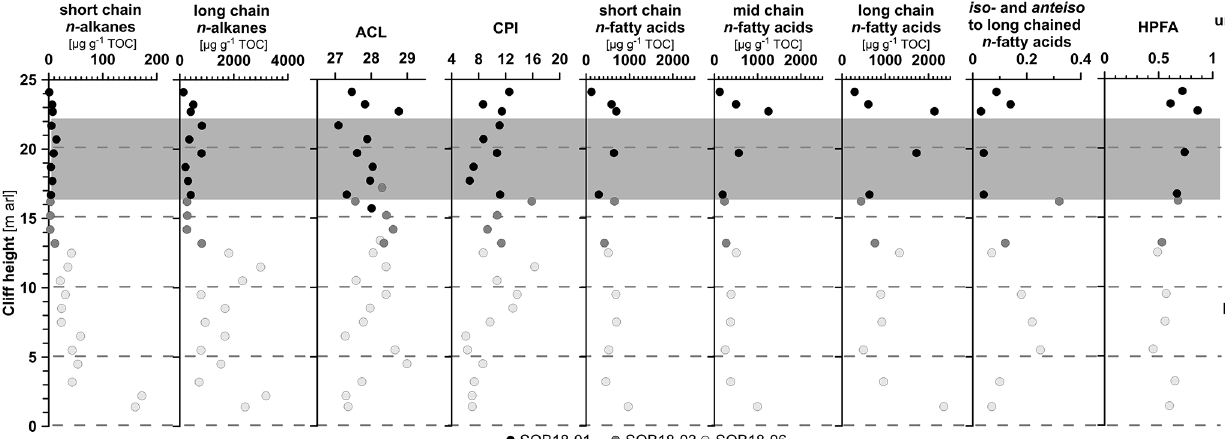
Figure 3. Biomarker parameters of the Sobo-Sise Yedoma cliff. The first four columns show n -alkane parameters: short-chain (C 14 –C 20 ) , and long-chain (C 21 –C 33 ) n -alkane concentrations (both in µgg − 1 TOC), the n -alkane average chain length (ACL 23 − 33 ) , and n -alkane carbon preference index (CPI 23 − 33 ) . The last five columns show n -fatty-acid parameters: short-chain (C 8 –C 20 ) , mid-chain (C 21 –C 23 ) and long-chain (C 24 –C 32 ) n -fatty-acid concentrations (inµgg − 1 TOC); the ratio of iso- and anteiso-branched saturated fatty acids (C 11 , C 13 , C 15 and C 17 ) to mid- and long-chain (C ≥ 21) n -fatty acids; and the higher plant fatty acid (HPFA) index. Data points are displayed over cliff height from the cliff top at 25m above river level (a.r.l.) to cliff bottom at 0ma.r.l. The three sections of SOB18 are plotted separately for each parameter (black, dark grey and light grey circles). Units I, II (grey rectangle) and III correspond to Marine Isotope Stage (MIS) 1 to